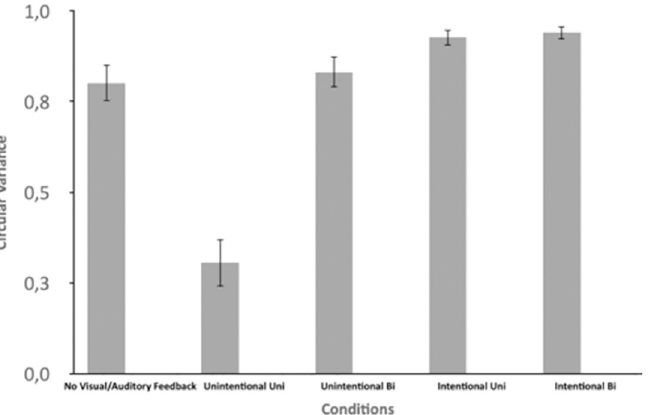
Fig 4. Circular variance of the relative phase time series. Note that circular variance is in unit-less and that 0 indicates no synchronization and 1 perfect synchronization.